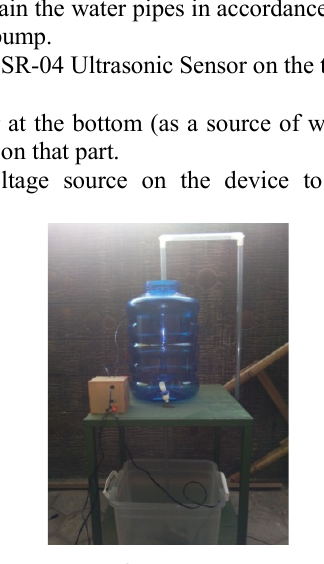
Figure 19. Overall Tool